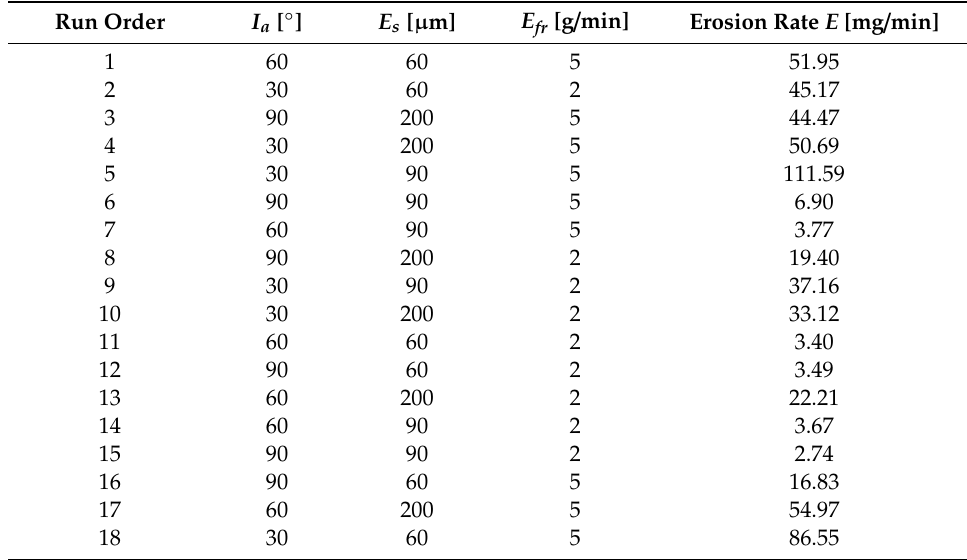
Table 6. Arrangement of the general full factorial design (GFFD) for the three independent variables and experimental values of the Erosion rate.